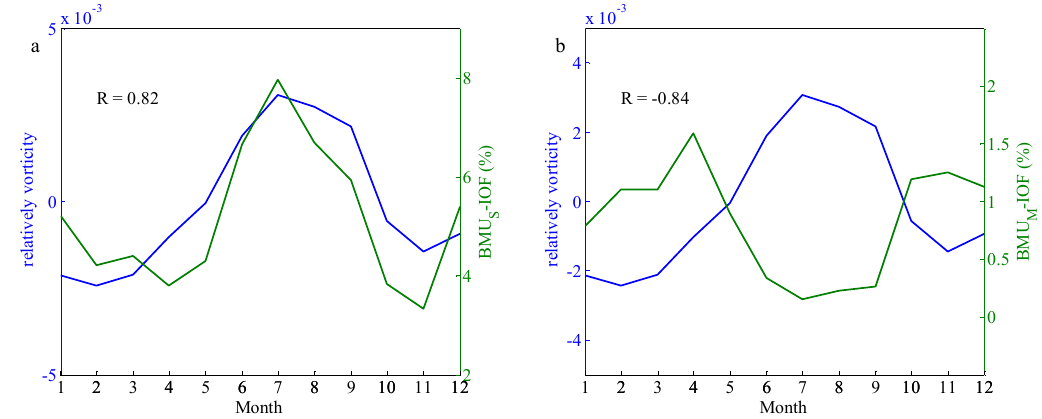
Figure 17. Comparisons of the mean relative viscosity in the region shown as the black square in Figure 16 and IOFs of BMU S ( a ) and BMU M ( b ) at the monthly scale. Correlation coefficients are 0.82 ( a ) and -0.84 ( b ).